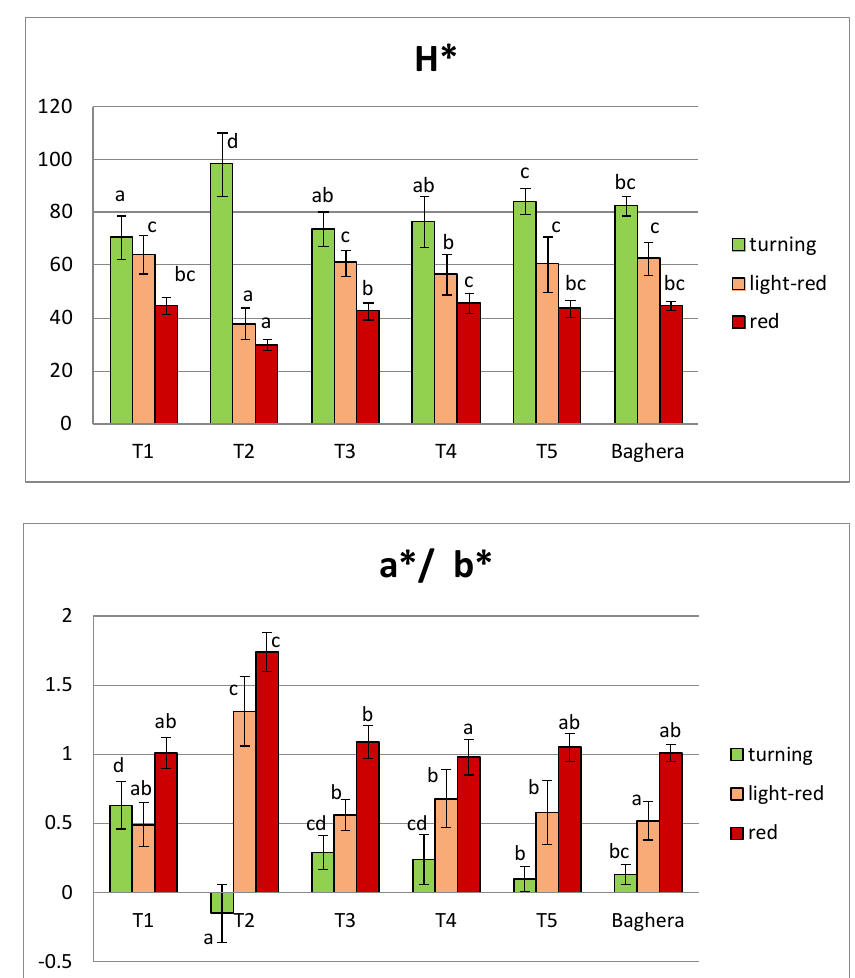
Figure 4. Tomato Hue angle and a*/b* ratio. For each ripening stage, different letters represent sig- nificant differences according to Tukey’s test ( p < 0.05). Mean values and standard deviation.